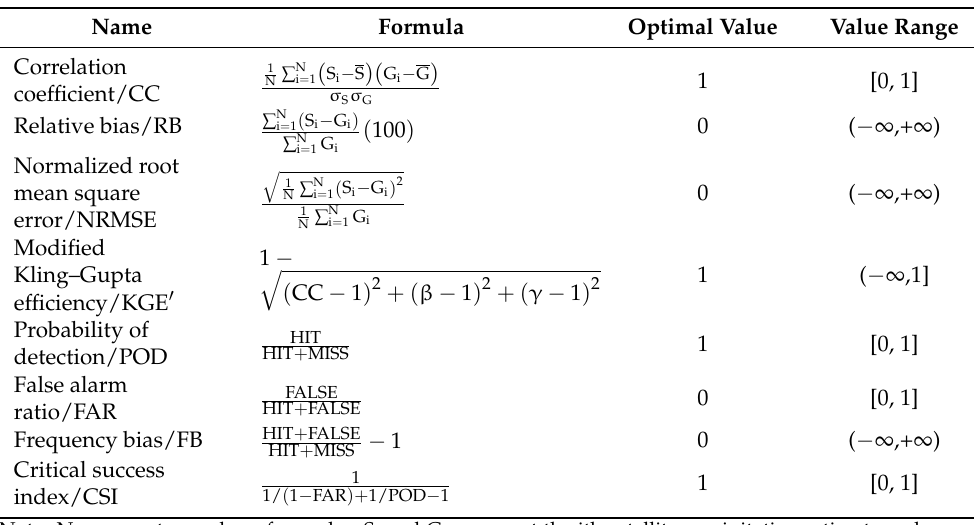
Table 2. Statistical